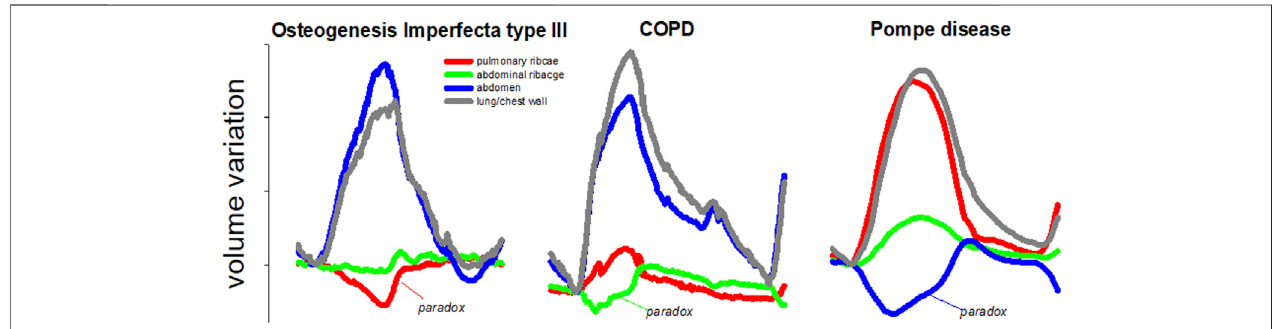
FIGURE 1 | Representative breaths during resting breathing in three different pathologies: Osteogenesis Imperfecta type III (left panel); chronic obstructive pulmonary disease (middle panel) and glycogen storage disease type 2 (right panel). The volume of the total chest wall (grey line) as well as of its three compartments, namely pulmonary ribcage (red line); abdominal ribcage (green line), and abdomen (blue line) are presented. The paradox of inspiratory inward movement, de fi ned as volume reduction, is also indicated for each pathology. These are original images of data previously published in papers dedicated to Osteogenesis Imperfecta (LoMauro et al., 2012); chronic obstructive pulmonary disease (Wilkens et al., 2010), and glycogen storage disease type 2 (Remiche et al., 2013).